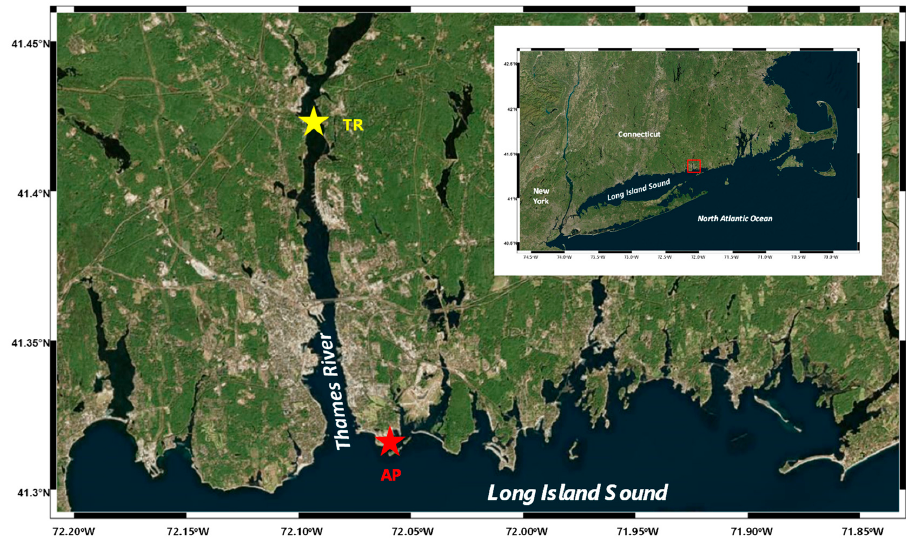
Figure 2. Study area and sampling sites. The red star denotes the coastal site of Avery Point (AP), while the yellow star denotes the estuarine site of the Thames River (TR).